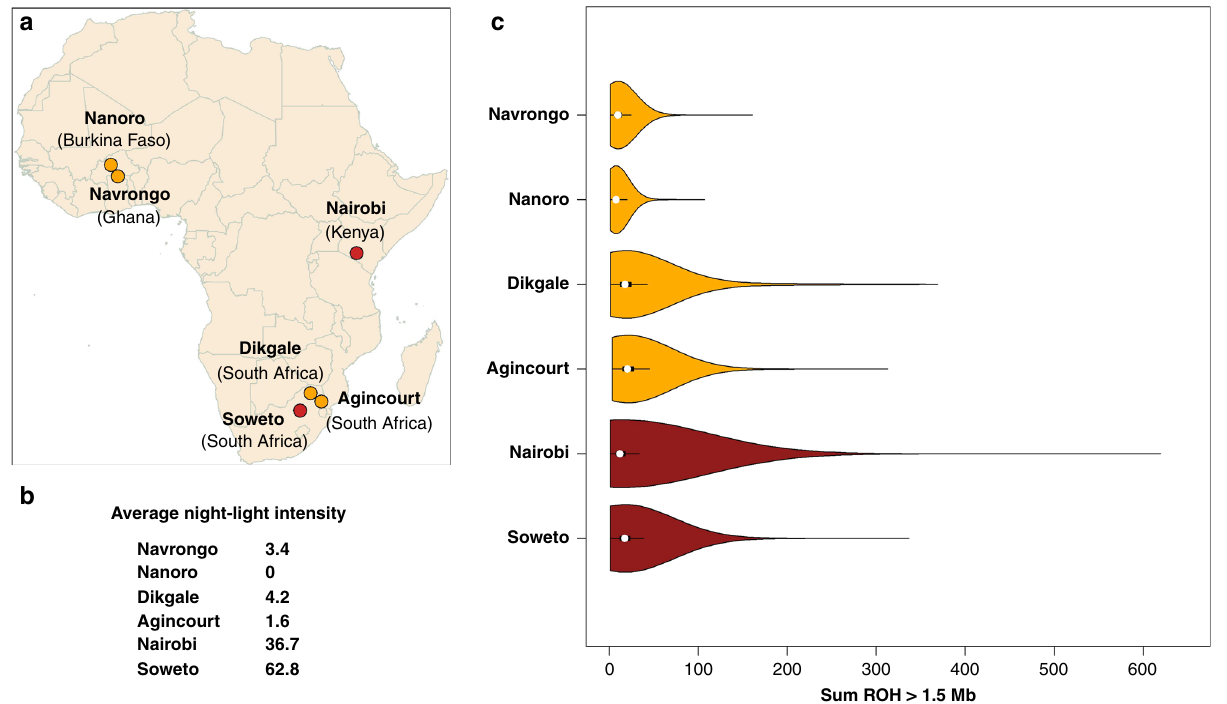
Fig. 1 Recruiting AWI-Gen study sites, night-light intensity and distribution of the sum of ROH (ROH > 1.5 Mb). a Locations of the recruitment sites for the AWI-Gen study. Nanoro (Burkina Faso) N = 1,983; Navrongo (Ghana) N = 1,844; Nairobi (Kenya) N = 1,771; Dikgale (South Africa (S.A.)) N = 1,143; Agincourt (S.A.) N = 2,094; Soweto (S.A.) N = 1,782. b Economic and urban development is proxied by 2013 night-light intensity data made available by the National Geophysical Data Centre (NGDC) of the National Oceanic and Atmospheric Administration of the U.S. Night-light values range from 0 (unlit) to 63. Sites with average light-night intensity below and above 5 are colored orange and red respectively. c Violin plot showing the distribution of ROH longer than 1.5 Mb for each study site. Medians with the interquartile range (IQR) are shown in Supplementary Table